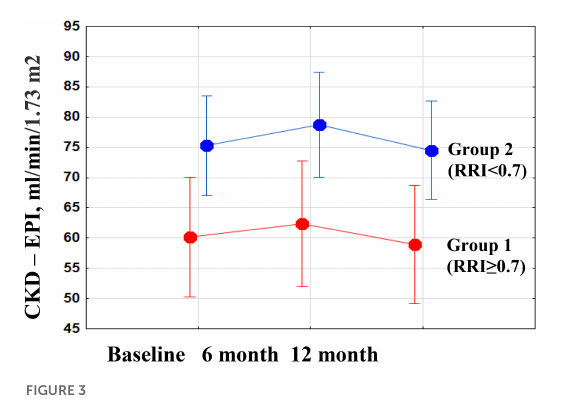
FIGURE3 Changes in estimated glomerular filtration rate (eGFR) during the year after renal denervation (RDN) in groups of patients with high and normal renal resistive index (RRI).